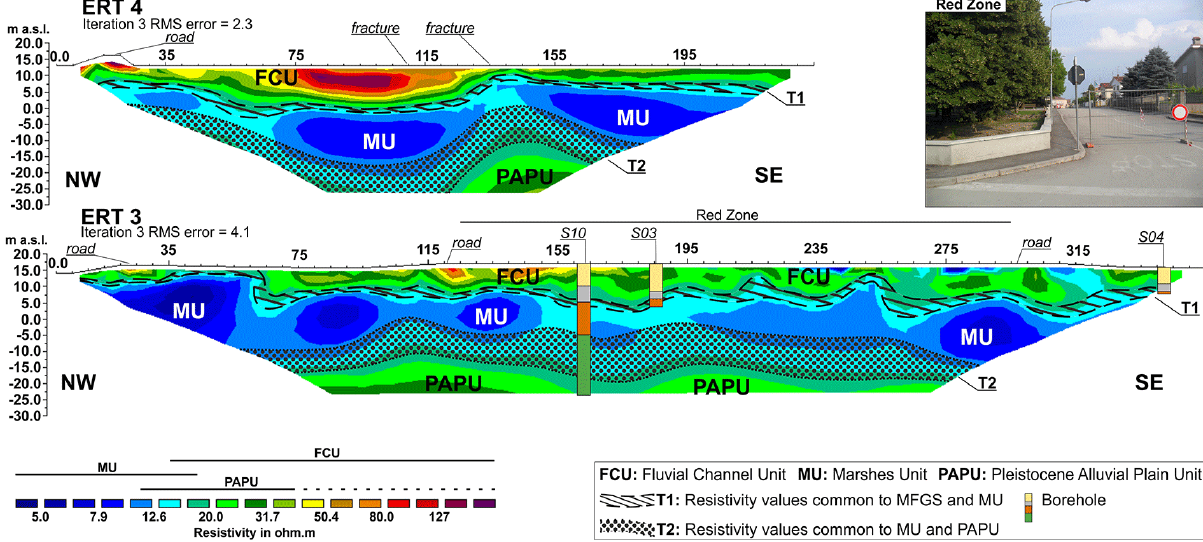
Fig. 4. ERT3 and ERT4 carried out in the western part of San Carlo and near the cemetery, respectively (see Fig. 1b for the location of ERT).